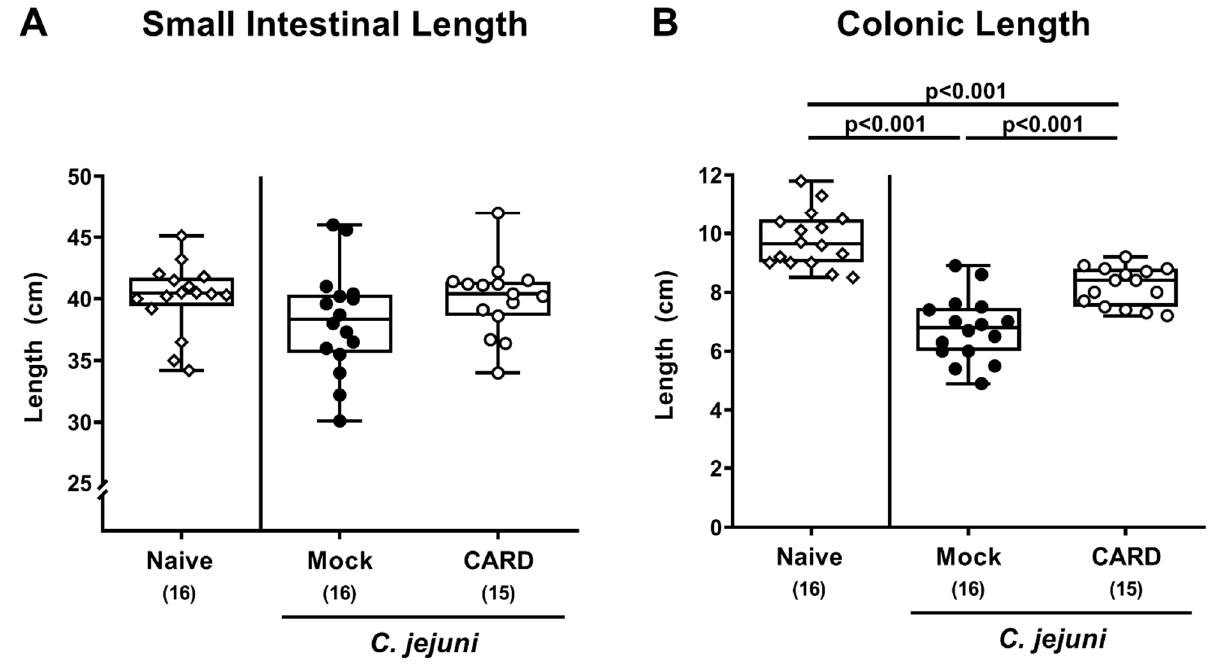
Figure 3. Intestinal lengths following oral cardamom essential oil application to C. jejuni -infected microbiota-depleted IL-10 − / − mice. Microbiota-depleted IL-10 − / − mice were infected with C. jejuni strain 81–176 on days 0 and 1 by gavage and perorally challenged with cardamom essential oil (CARD; white circles) via the drinking water starting on day 2 post-infection, whereas mock control mice received vehicle (black circles). On day 6 post-infection, the ( A ) small intestinal and ( B ) colonic lengths were measured with a ruler. Naive mice (open diamonds) served as untreated and uninfected controls. The box plots indicating the 75th and the 25th percentiles of the median (black bar within box), the total range, the levels of significance ( p values) as calculated with the Kruskal–Wallis test and Dunn’s post-correction, and the number of analyzed mice (in parentheses) are shown. Data were pooled from four independent experiments.